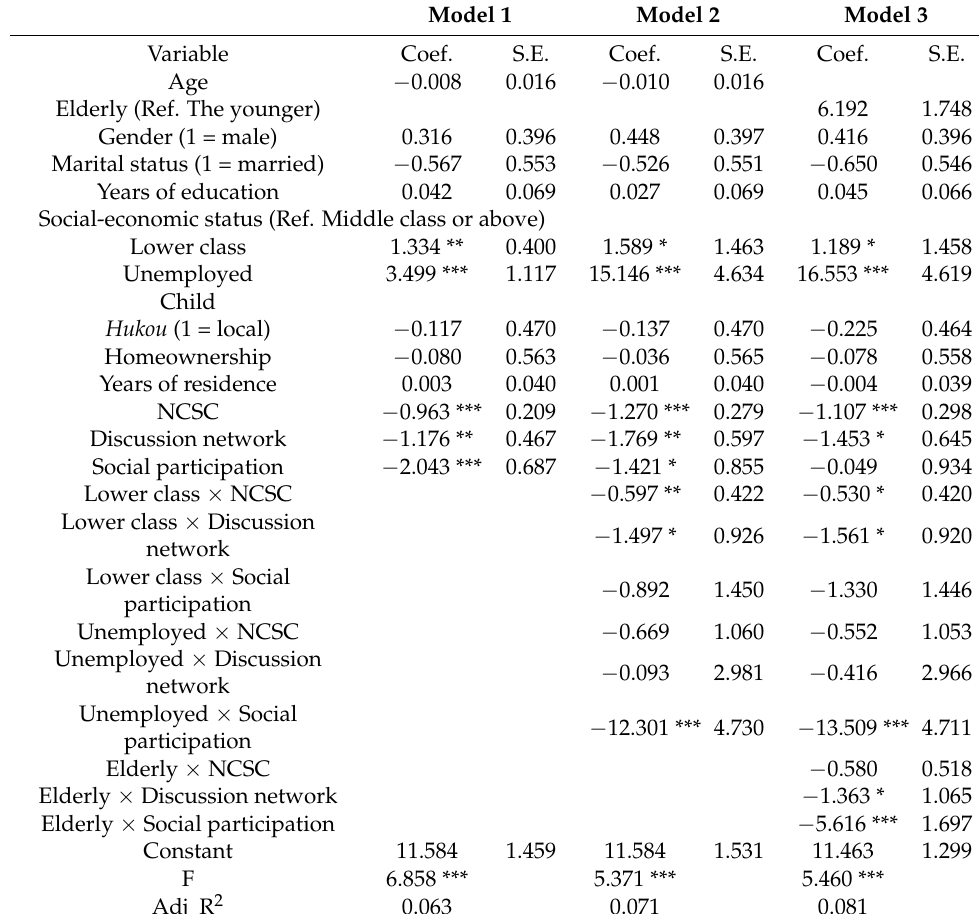
Table 3. Relationship between NSC and depressive